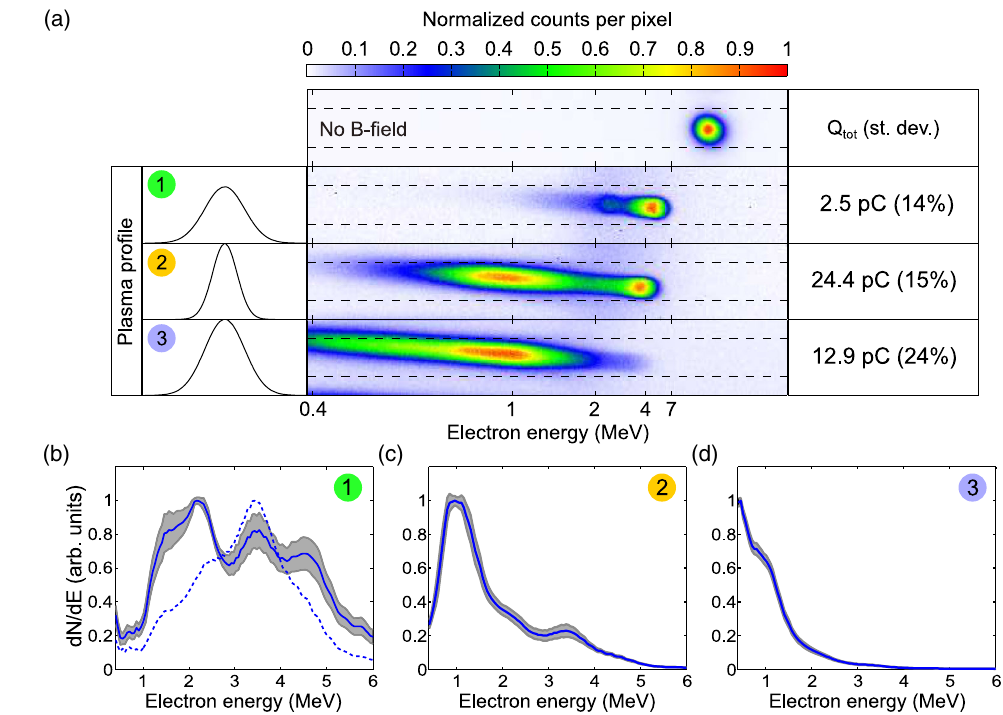
FIG. 4. Electron spectra and measured average charges for three different target density profiles from the supersonic jet. (a) Raw data and average charge values. Top row — electron beam spatially filtered by a pinhole but not deviated by magnets. Case 1 — spectrum obtained with peak electron density 1 . 45 × 10 20 cm − 3 and 1 =e width of 65 μ m. Case 2 corresponds to the case with 1 . 7 × 10 20 cm − 3 peak and 55 μ m width, case 3 — with 1 . 6 × 10 20 cm − 3 peak and 70 μ m width. (b) Solid line — deconvolved spectrum 1 with standard deviation (grey area). Dashed line — deconvolved spectrum when the driver pulse was negatively chirped by − 4 fs 2 (raw data not given). (c) and (d) Deconvolved spectra 2 and 3 with corresponding standard